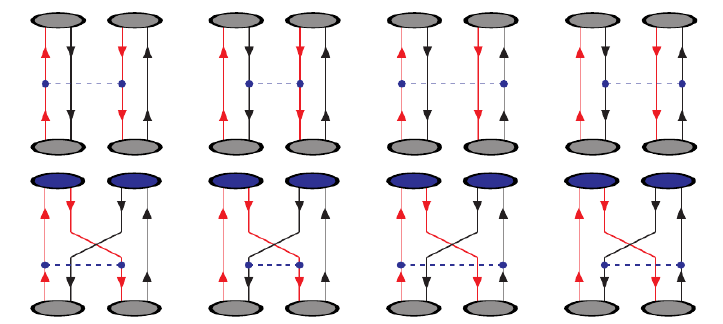
Figure 1. Diagrams that contribute to the interaction between mesons and rearrangement